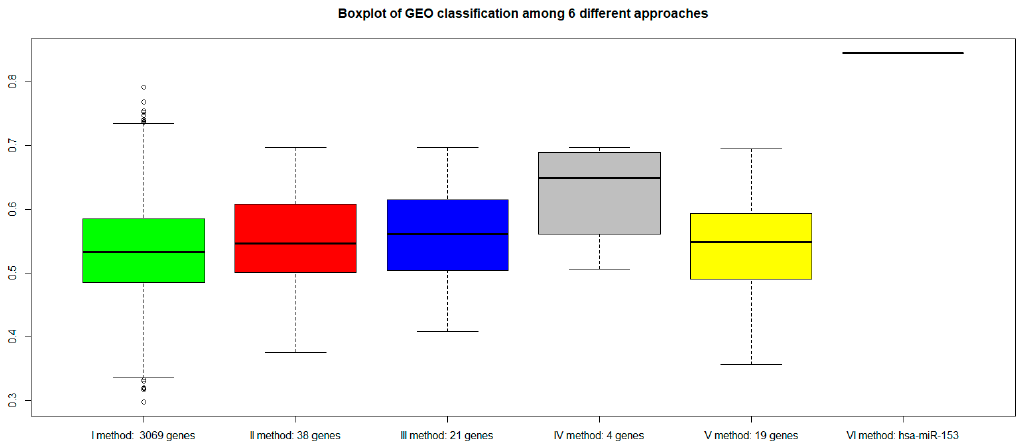
Figure 7. AUC values of six different approaches with a validation dataset GEO (GSE79021 for gene expression, and GSE21036 for miRNA): green bar (I method with 3069 genes), red bar (II method with 38 genes), blue bar (III method with 21 genes), gray bar (IV method with 4 genes), yellow bar (V method with 19 genes), and pink bar (VI method with hsa-miR-153 ).